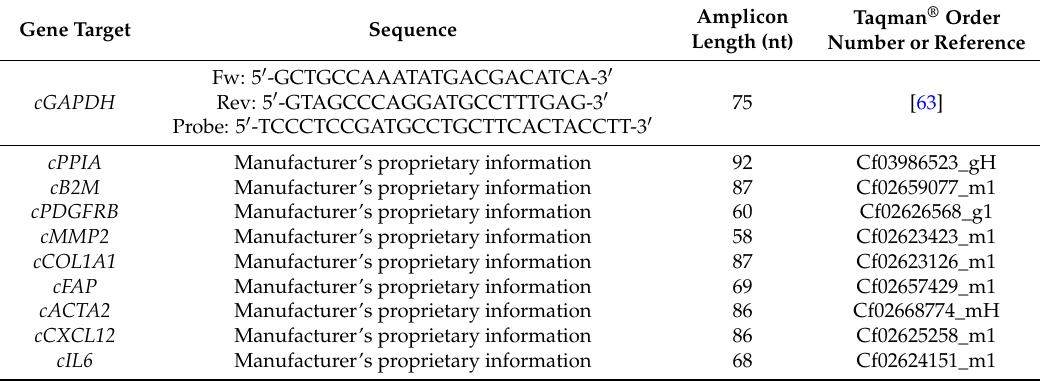
Table 4. List of primers used for RT-qPCR. The “c” before each gene indicates that primers were designed to detect the canine isoforms of the intended